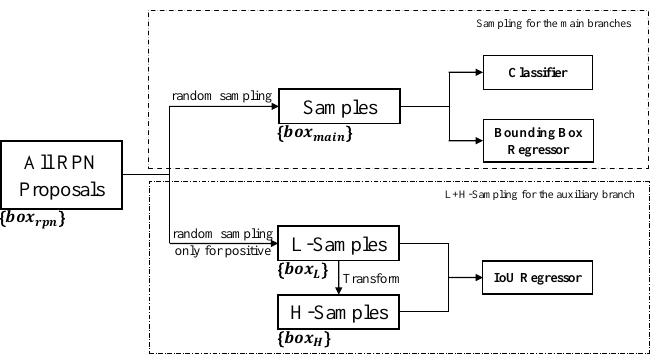
Figure 2. For the main branches and the auxiliary branch, we separately take samples from the RPN proposals box rpn , adopting different sampling strategies. Note that the Transform refers to using the bounding box regressor in the main branches to refine the L-Samples and obtain the H-Samples.